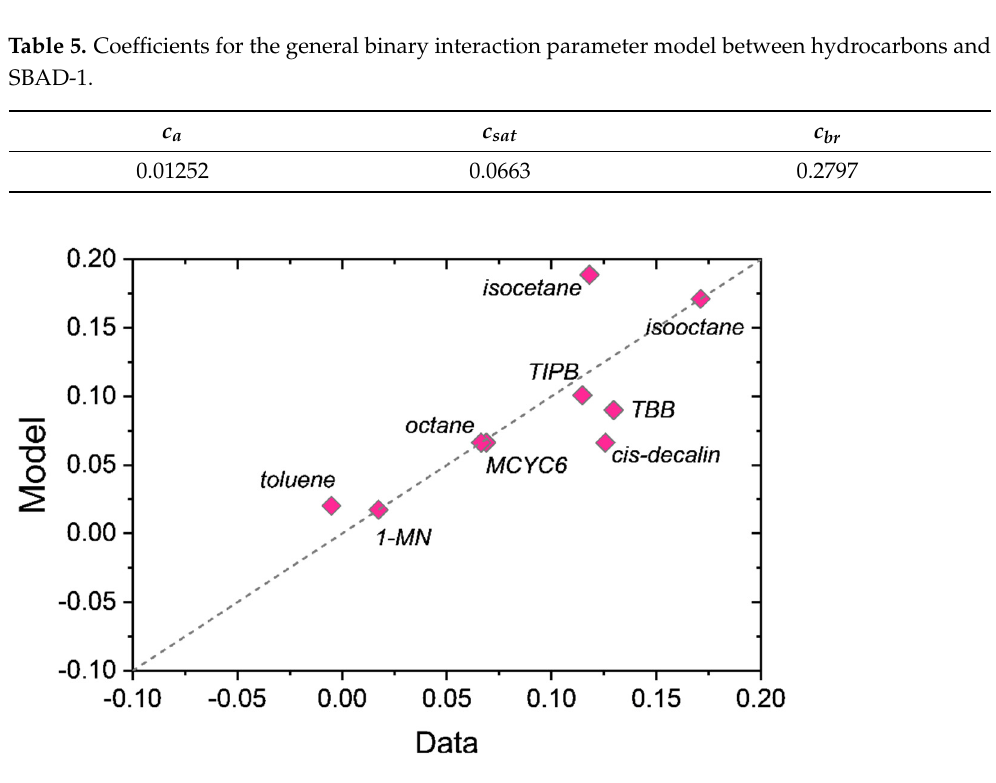
Figure 6. Parity plot of correlation predicted binary interaction parameters (Equation (15)) versus data values from Table 3. Table 5. Coefficients for the general binary interaction parameter model between hydrocarbons and SBAD-1.